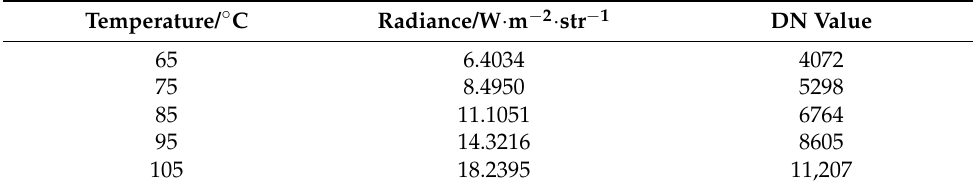
Figure 6. Blackbody source in field test with different temperatures in degree C: ( a ) 65; ( b ) 75; ( c ) 85; ( d ) 95; ( e ) 105. The radiance calculated according to Planck’ law of radiation and corresponding DN value are listed in Table 4. Table 4. Radiance and DN value for the blackbody test.